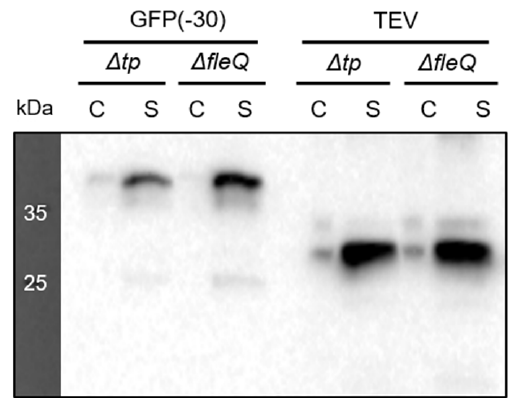
Figure 3. Comparison of P. fluorescens Δ tp and Δ fleQ recombinant protein secretion. The cell lysate is labeled C and the supernatant is labeled S. Intracellular expression and secretion was detected